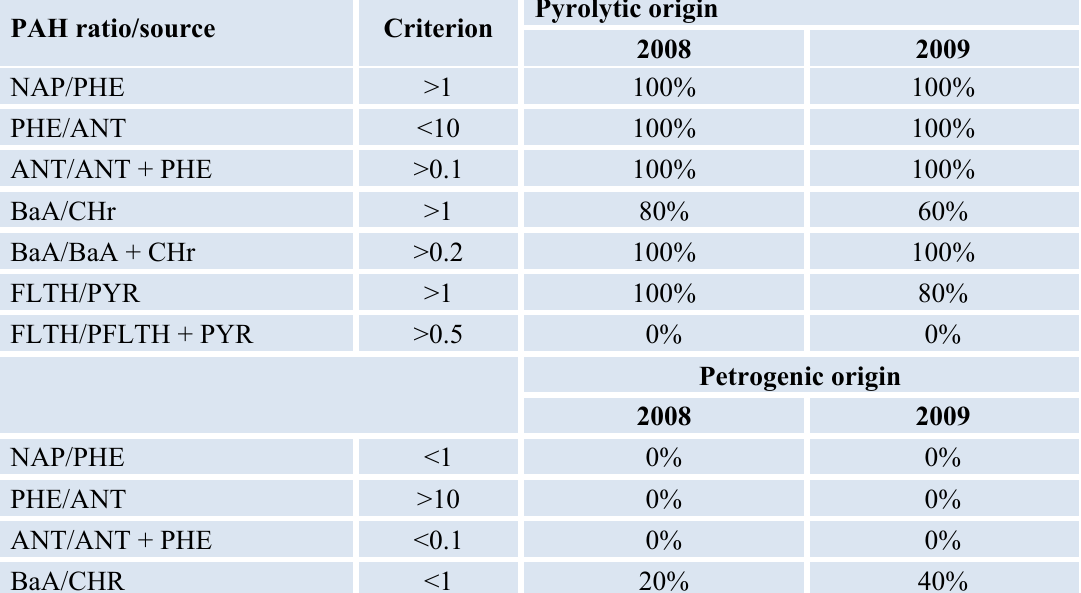
Table 5. Percentage relationship between pyrolytic, petrogenic and other sources of PAH emissions at Gda ń sk airport in